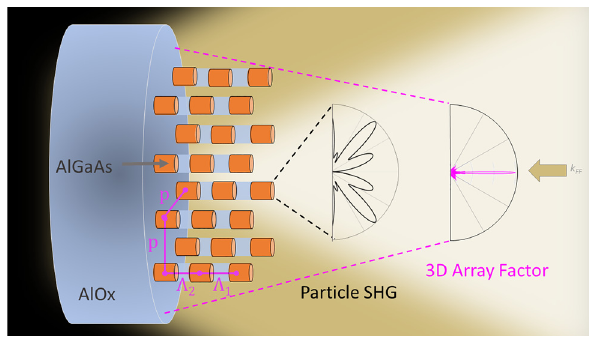
Figure 1: Schematic of a three-layer metasurface ( Λ 1 and Λ 2 apart from each other)with SHemissionpatterndecomposedin SHG from the single nanoresonator (dark line) and array factor radiation from the 3D array with in-plane periodicity p (pink